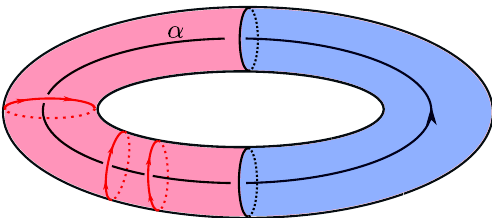
Figure 17 . States on the torus can be prepared via the interior path integral with a longitudinal Wilson line insertion ( (cid:11) in this (cid:12)gure). For this particular bipartition, a natural candidate for is generated by meridian Wilson loop operators acting in the A region (depicted here in